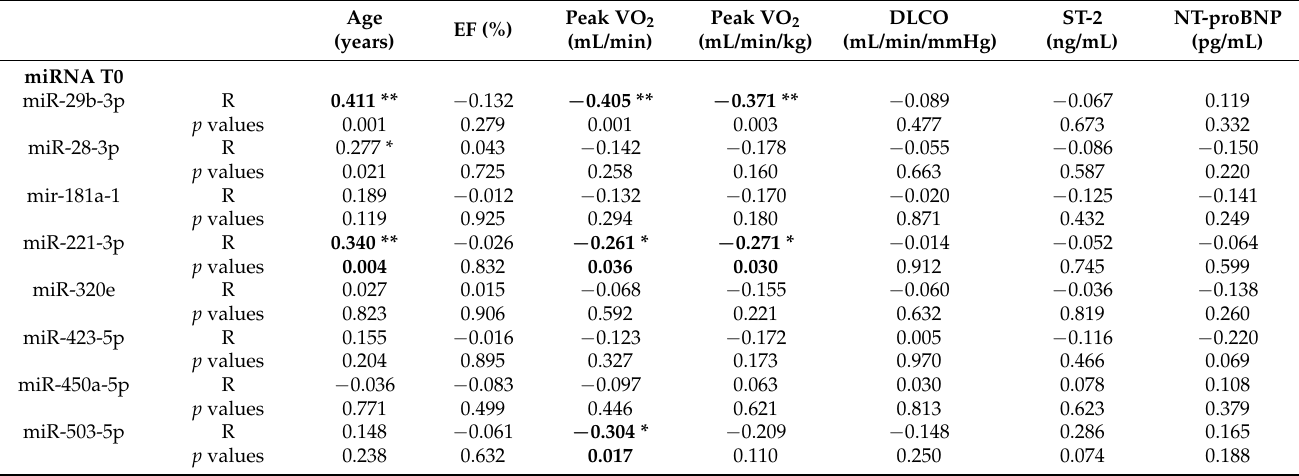
Table 3. Spearman’s correlation between basal levels of circulating miRNAs and clinical parameters at